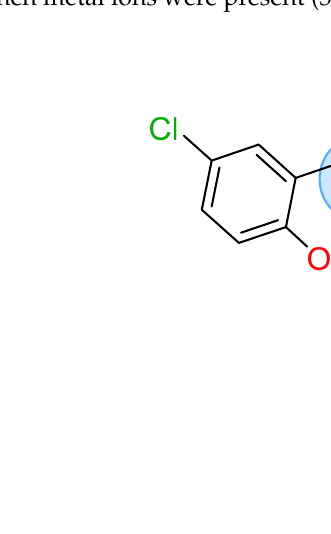
Figure 2. Structure of ( a ) tridentate Schiff base and ( b ) its palladium pincer complex with antimicrobial activity.